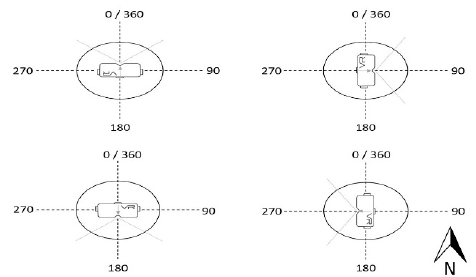
Figure 1. Orientation of VR headsets on observers during each one-minute view within the VR display room. Note the field of view from the headset is 110°, so some overlap between views was expected at each view point.